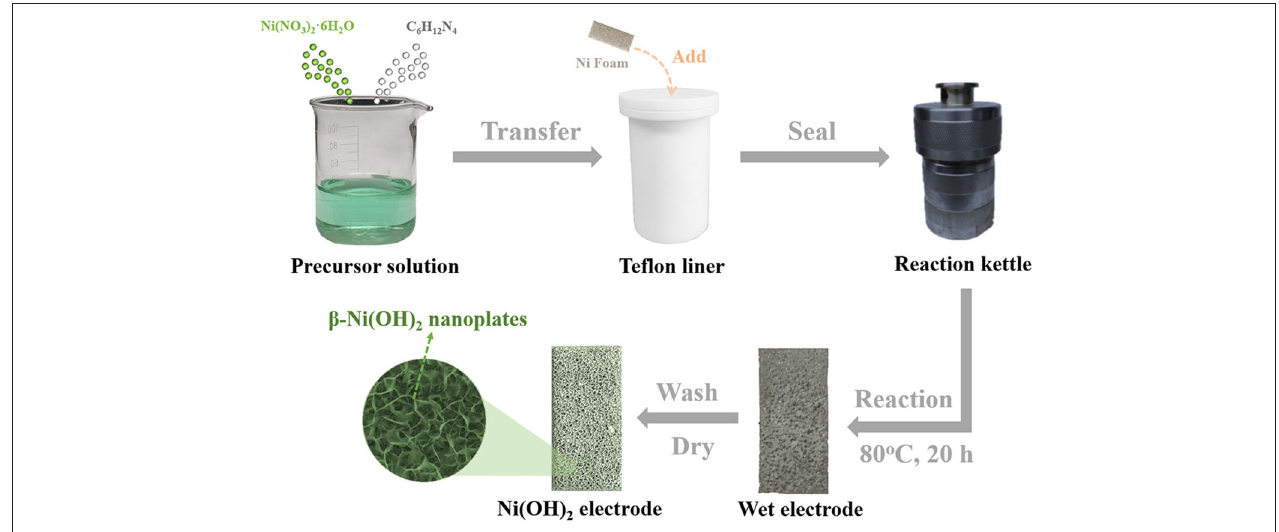
FIGURE 1 | Schematic illustration of the procedure for the synthesis of ultra-thin β -Ni(OH) 2